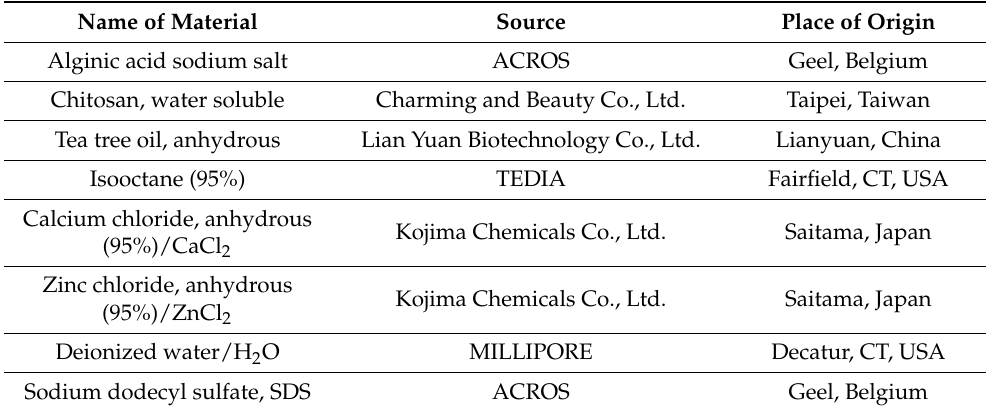
Table 1. Introduction of sources and places of origin of experimental materials and